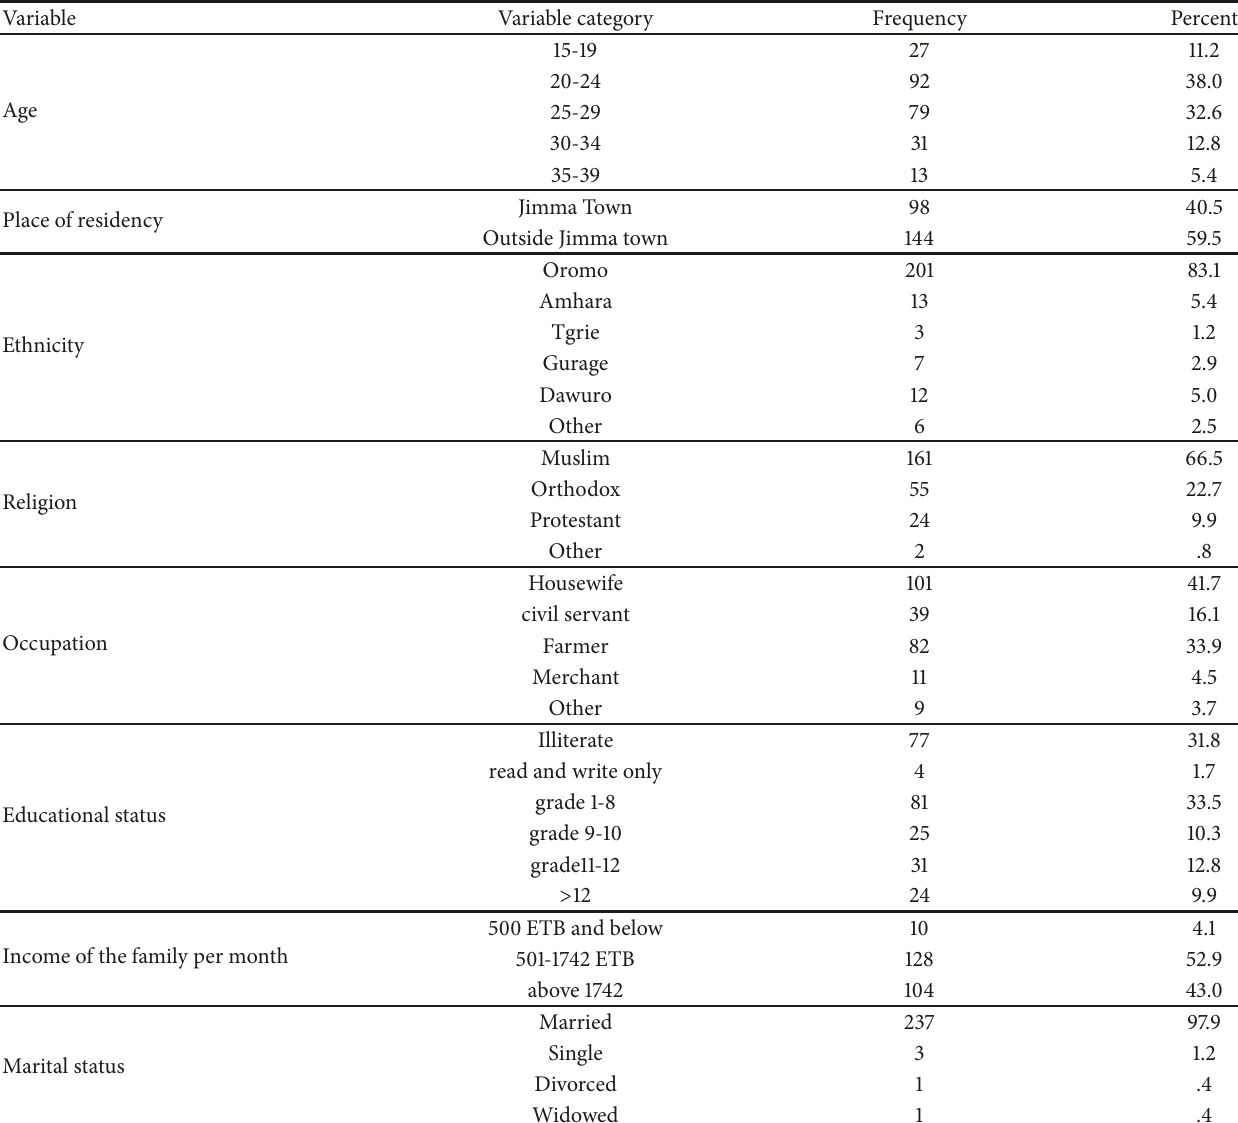
Table 1: Frequency distribution of sociodemographic characteristics of mothers who gave birth by OVD in JUMC December 1, 2016–May 30, 2017.